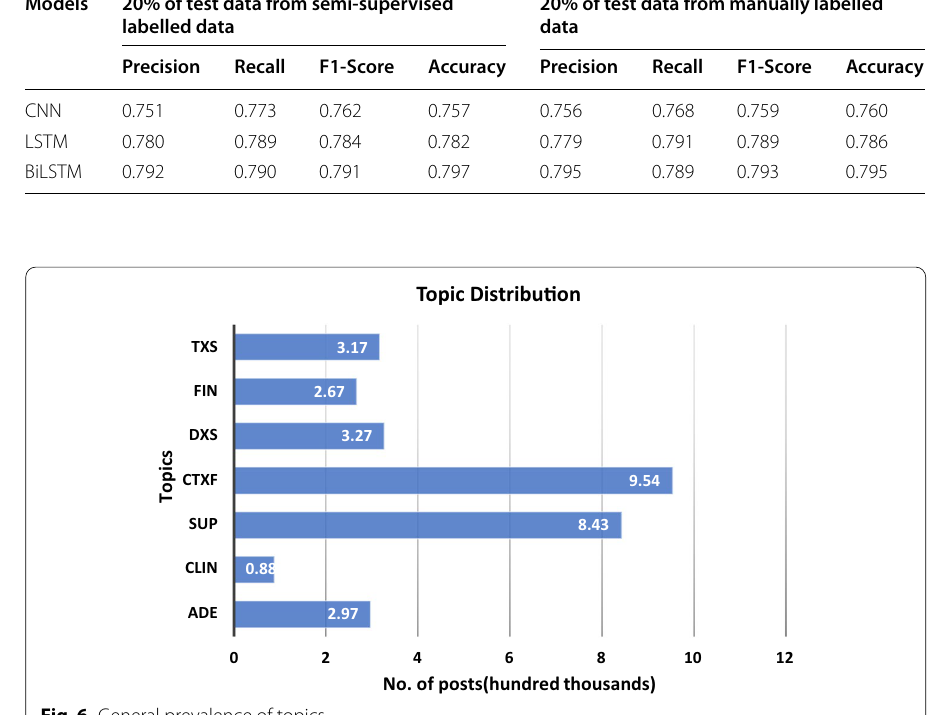
Fig. 6 General prevalence of